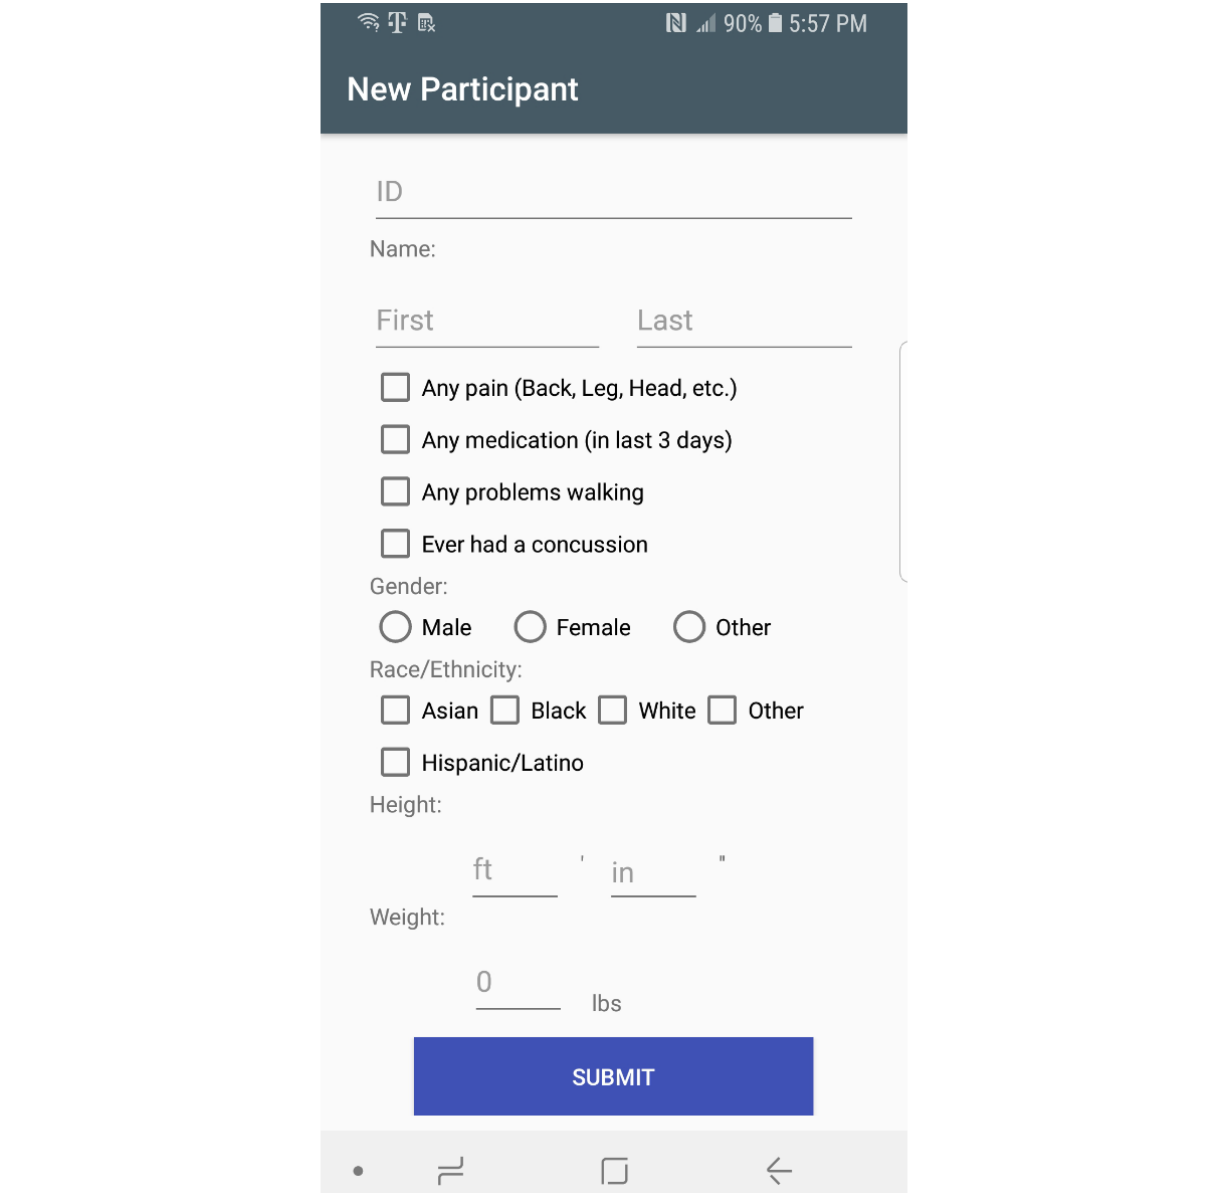
Figure 1. Main fragment of the mobile health